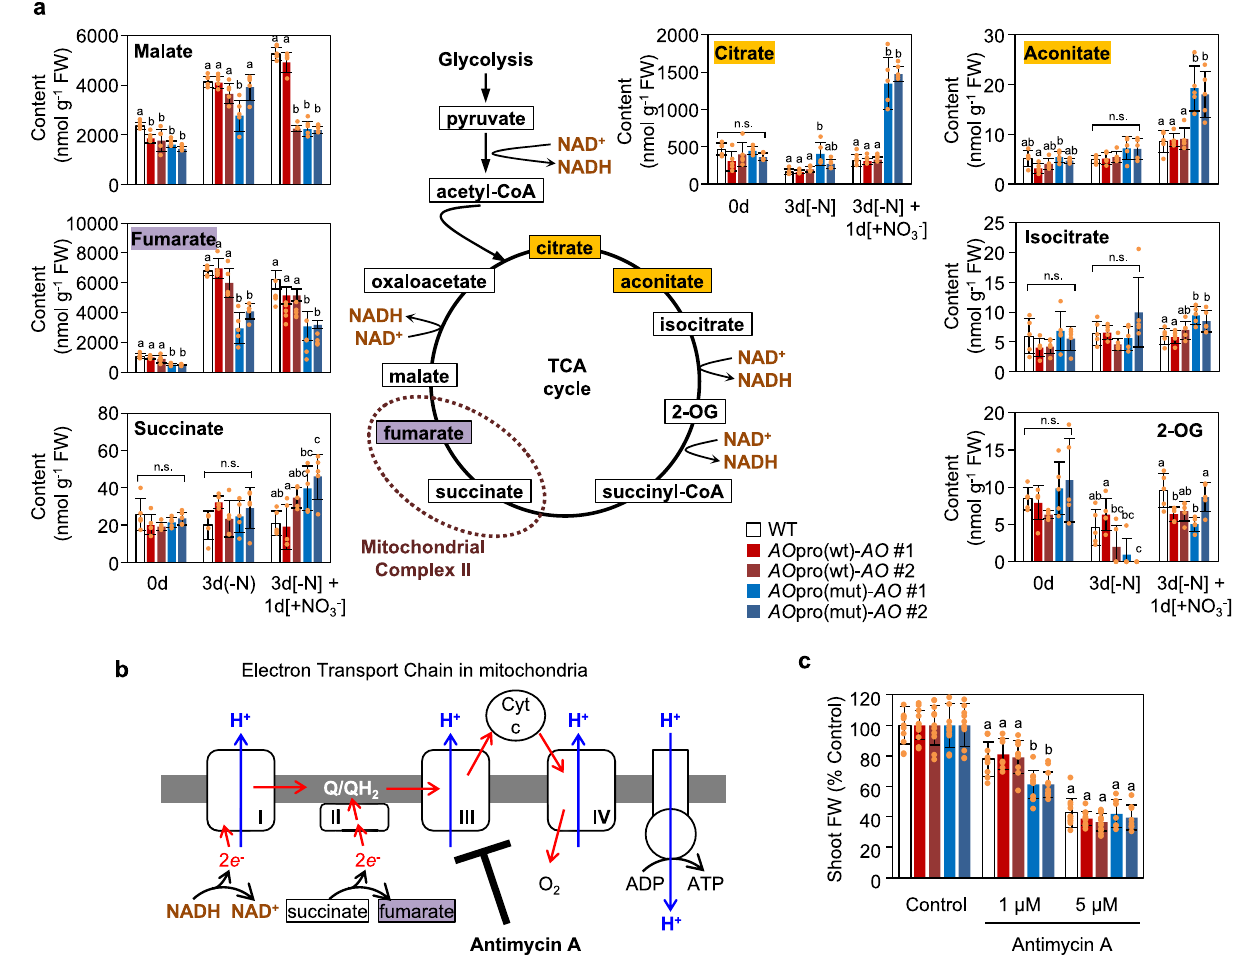
Fig. 6 Abnormal accumulation of TCA cycle metabolites in AO pro(mut)- AO plants. a Contents of TCA cycle intermediates were measured in the shoots of WT, AO pro(wt)- AO , and AO pro(mut)- AO plants grown according to the scheme shown in Fig. 5a. Data represent mean ± SD ( n = 5). b Schematic representation of the mitochondrial electron transport chain. Antimycin A inhibits the activity of Complex III. Q, ubiquinone; QH 2 , ubiquinol. c Effect of antimycin A on the shoot fresh weight. Seedlings were initially grown in the absence of antimycin A for 4 days and then in the presence of the indicated concentrations of antimycin A for 6 days ( n = 7 – 12). Two independent lines (#1 and #2) of AO pro(wt)- AO and AO pro(mut)- AO plants were used. In ( a , c ), different letters denote statistically signi fi cant differences (Tukey ’ s HSD test; P <